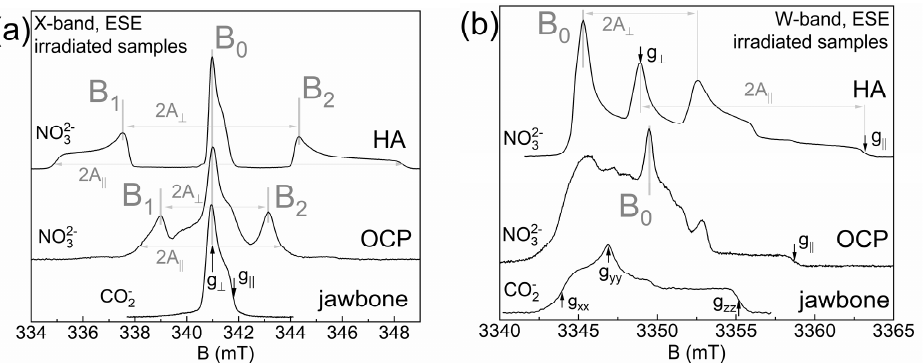
Figure 1. EPR spectra of the irradiated samples in pulse mode for the ( a ) X-band and ( b ) W-band frequency ranges at T = 297 K. frequency ranges at T = 297 K.